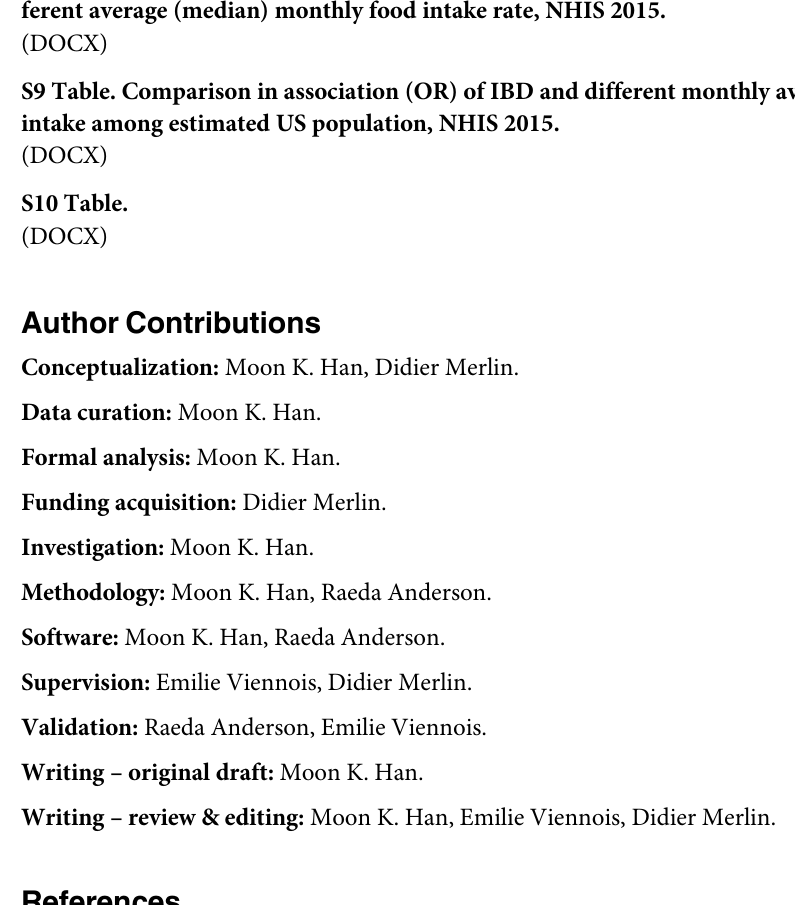
S5 Table. Association (OR) of food consumption (full model) and IBD in estimated US population, NHIS 2015. S6 Table. Association (OR) of food consumption frequency (full model) and IBD in esti- mated US population, NHIS 2015. S7 Table. Population size and average (median) monthly food intake frequency for US sample adults and estimated adult population, NHIS 2015. S8 Table. Comparison in point prevalence of colitis in estimated subpopulation with dif- ferent average (median) monthly food intake rate, NHIS 2015. S9 Table. Comparison in association (OR) of IBD and different monthly average food intake among estimated US population, NHIS